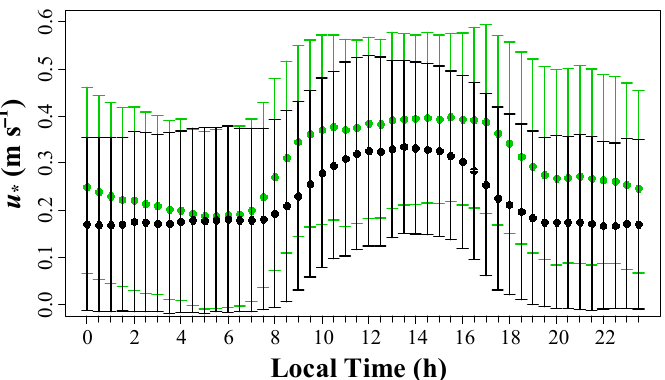
Figure 5. Diurnal variation of the mean and standard deviation of friction velocity during the growing season (green) and dormant season (black). Error bars represent the standard deviation of friction velocity.